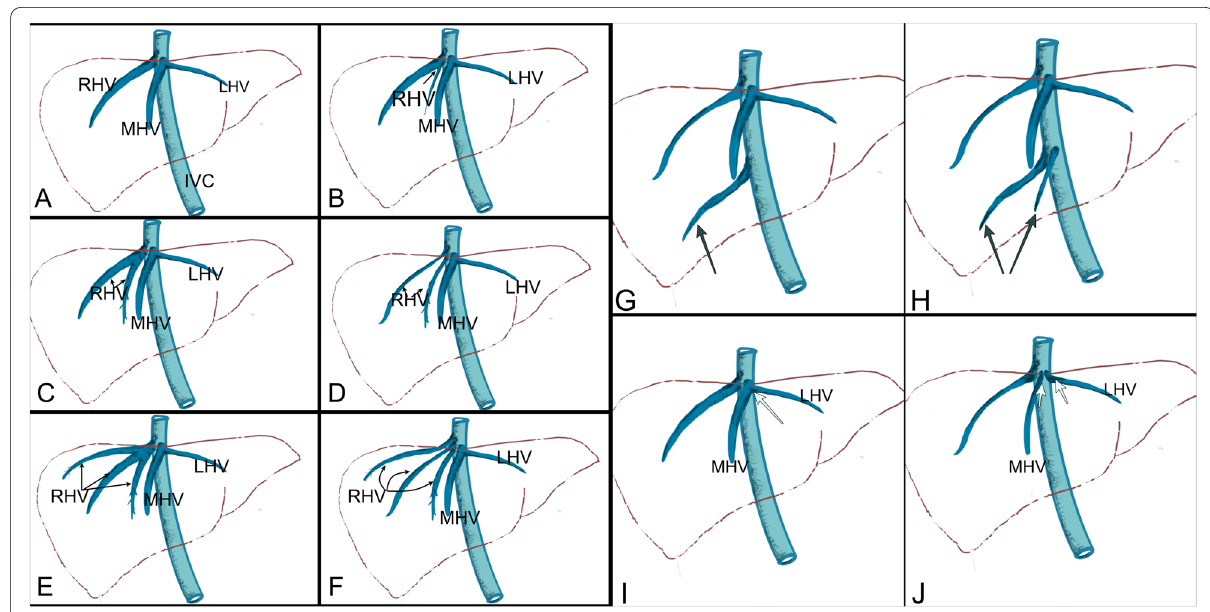
Fig. 3 Schematic representation of right hepatic vein variants in our study. A Single right hepatic vein (RHV). B Early branching RHV. C Two RHV common trunks. D Two RHV independent drainage. E Three RHV common trunks. F Three RHV independent drainage. G Single accessory inferior RHV. H Two accessory inferior RHVs. I Common trunk of drainage of the middle hepatic vein (MHV) and left hepatic vein (LHV). J Independent drainage of